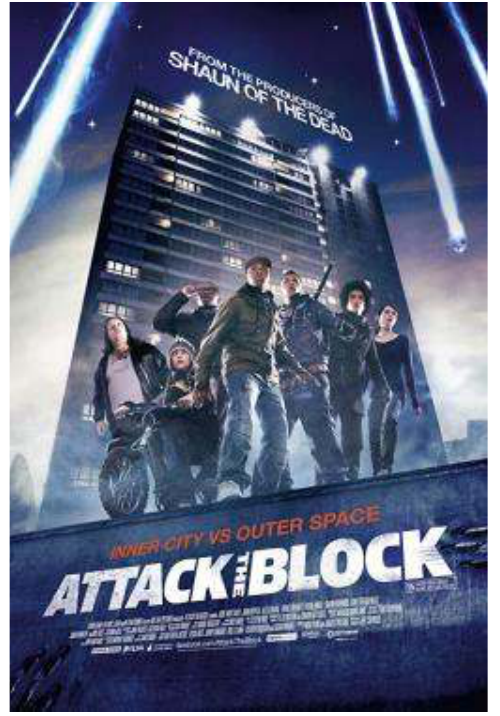
Figure 8. “Hoodie horror for